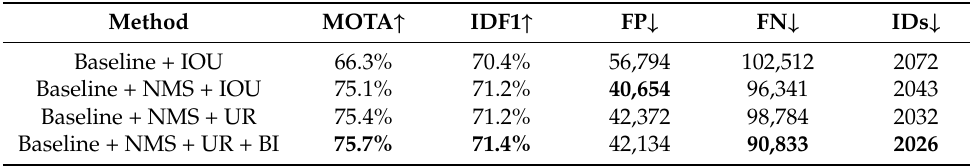
Table 3. Ablation results on MOT20.